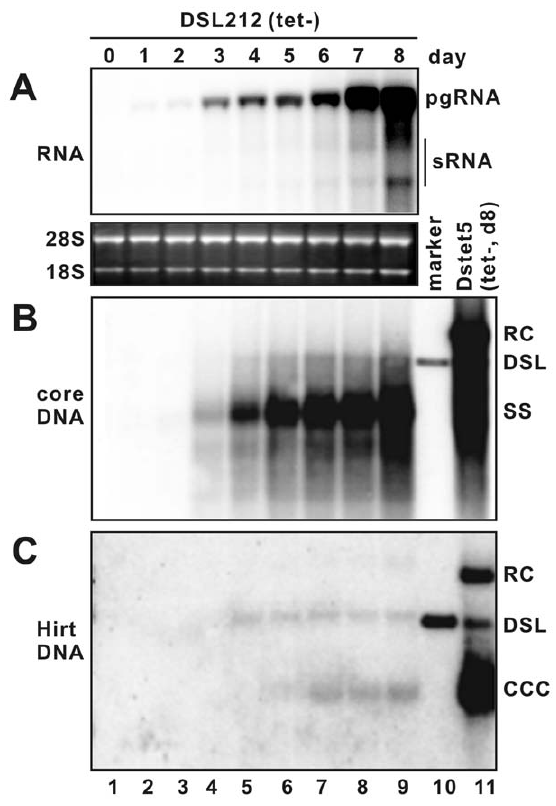
Figure 1. Kinetics of DHBV RNA transcription, DNA replication and cccDNA formation in DSL212 cells. DSL212 cells were seeded in 6-well plates and cultured in the presence of tetracycline (1 m g/ml) until cell monolayers became confluent. Cells were then cultured in media without tetracycline and harvested at the indicated days since the removal of tetracycline. Total cellular RNA, cytoplasmic core DNA and total cellular Hirt DNA were extracted and analyzed by Northern and Southern blot hybridization, respectively. (A) For viral RNA analysis, each lane was loaded with 5 m g of total RNA. pgRNA, pregenomic RNA; sRNA, mRNAs specifying the two envelope proteins. Ribosomal RNA (28S and 18S) served as loading controls. For DHBV core DNA (B) and Hirt DNA (C) analysis, each lane represents the amount of viral DNA extracted from one half of cells in a well of 6-well plate. RC, relaxed circular DNA; DSL, double stranded linear DNA; SS. single stranded DNA; cccDNA, covalently-closed circular DNA. Unit length of linear DHBV DNA (lane 10) and core or Hirt DNA extracted from dstet5 cells [40] cultured in the absence of tetracycline for 8 days (lane 11) served as controls. doi:10.1371/journal.pone.0043270.g001 Figure 2. Subcellular distribution of DHBV DNA replication above cell lines were infected with a recombinant adenoviral